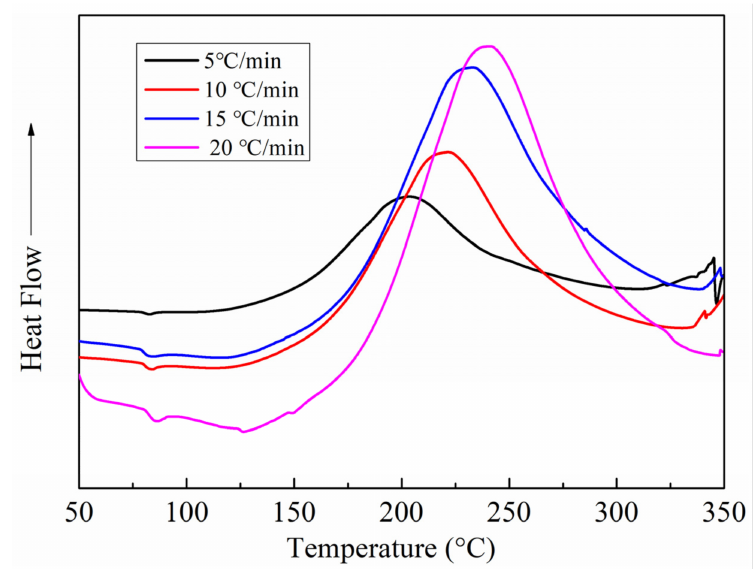
Figure 3. Differential scanning calorimetry (DSC) curves of the matrix resin of the wet peel ply.